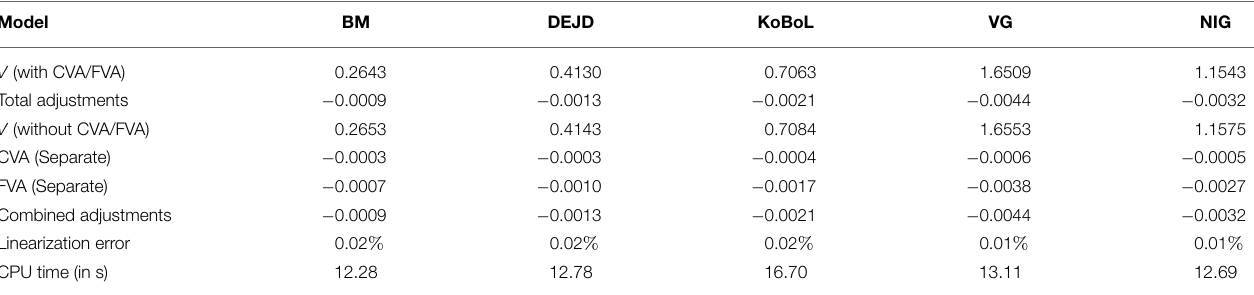
TABLE 9 | Prices of at-the-money down-and-out put for different models as of 9 January 2015, time to maturity T = 0 . 463 , spot, strike S = K = 24 , 000 , barrier H = 23 , 500 , risk-free rate r = 0 . 52 % , collateral rate r C = 1 % , funding rate r F = 1 . 7 % default intensity λ = 0 . 05 , recovery rate R B = 0 . 4 , collateral threshold H B = 0 . 1 .